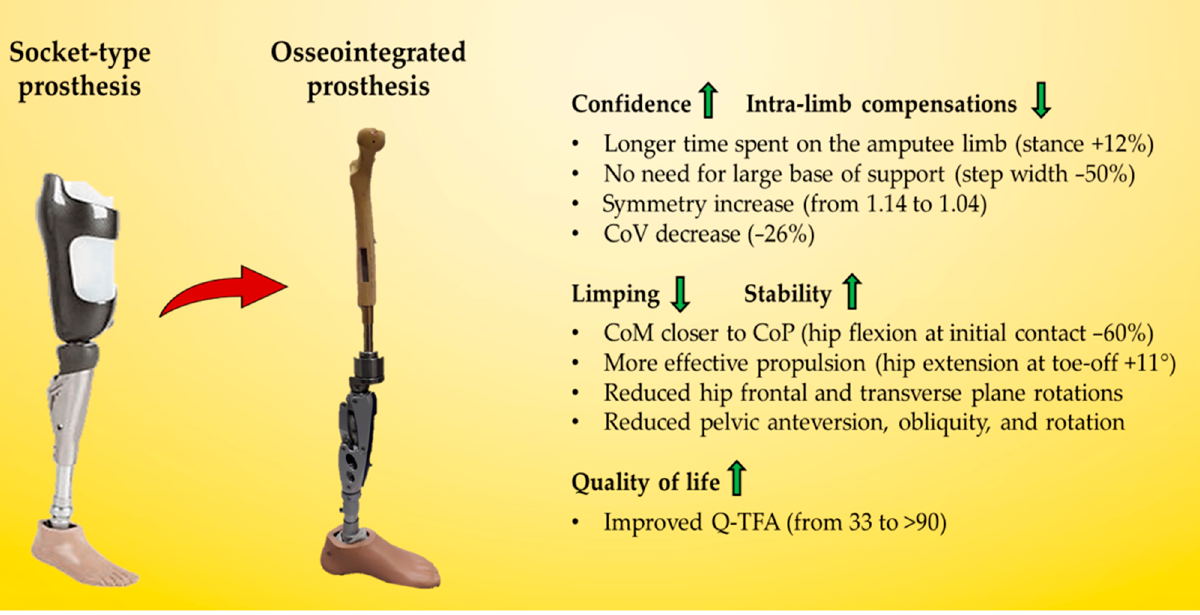
Figure 8. Summary of the functional and quality of life improvements in the patient from socket-type prosthesis to one-year after osseointegrated prosthesis surgery.